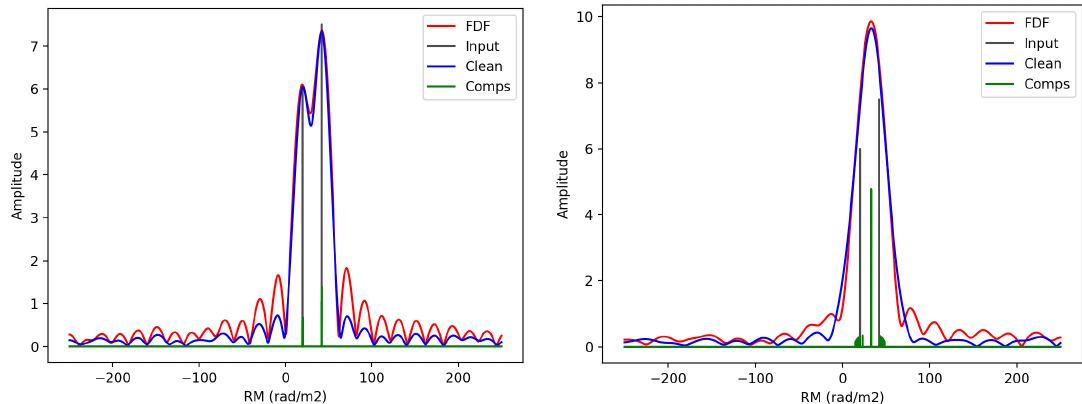
Figure 2. Examples of the results of the RM CLEAN. The left and right figures show the results for the model d 2 using the frequency band case I and case II, respectively.